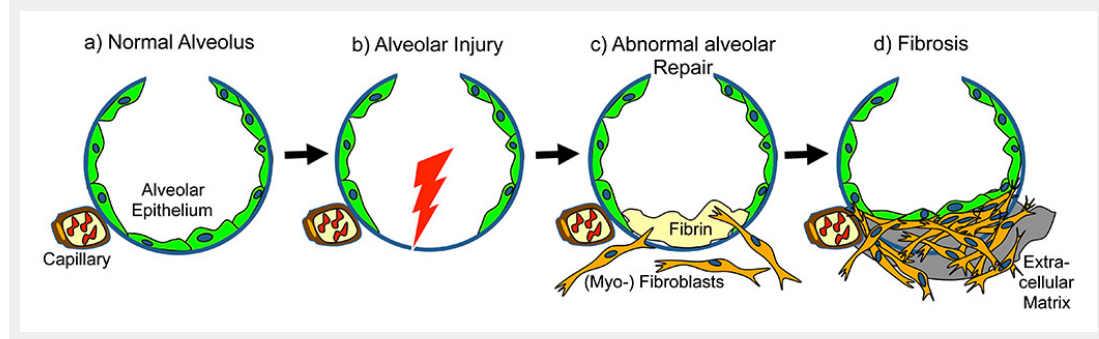
Figure 3 Hypothesis for pathophysiological mechanisms of idiopathic pulmonary fibrosis development. Normal alveolar epithelium (fig. 3a) is injured by various mechanisms (fig. 3b). Alveolar epithelial cells undergo apoptosis and the resulting gap is filled with a fibrin clot (fig. 3c). Fibroblasts migrate in and proliferate (fig. 3c), and differentiate into myofibroblasts. Extracellular matrix is produced (fig. 3d) and accumulated fibroblasts further infiltrate the interstitium leading to